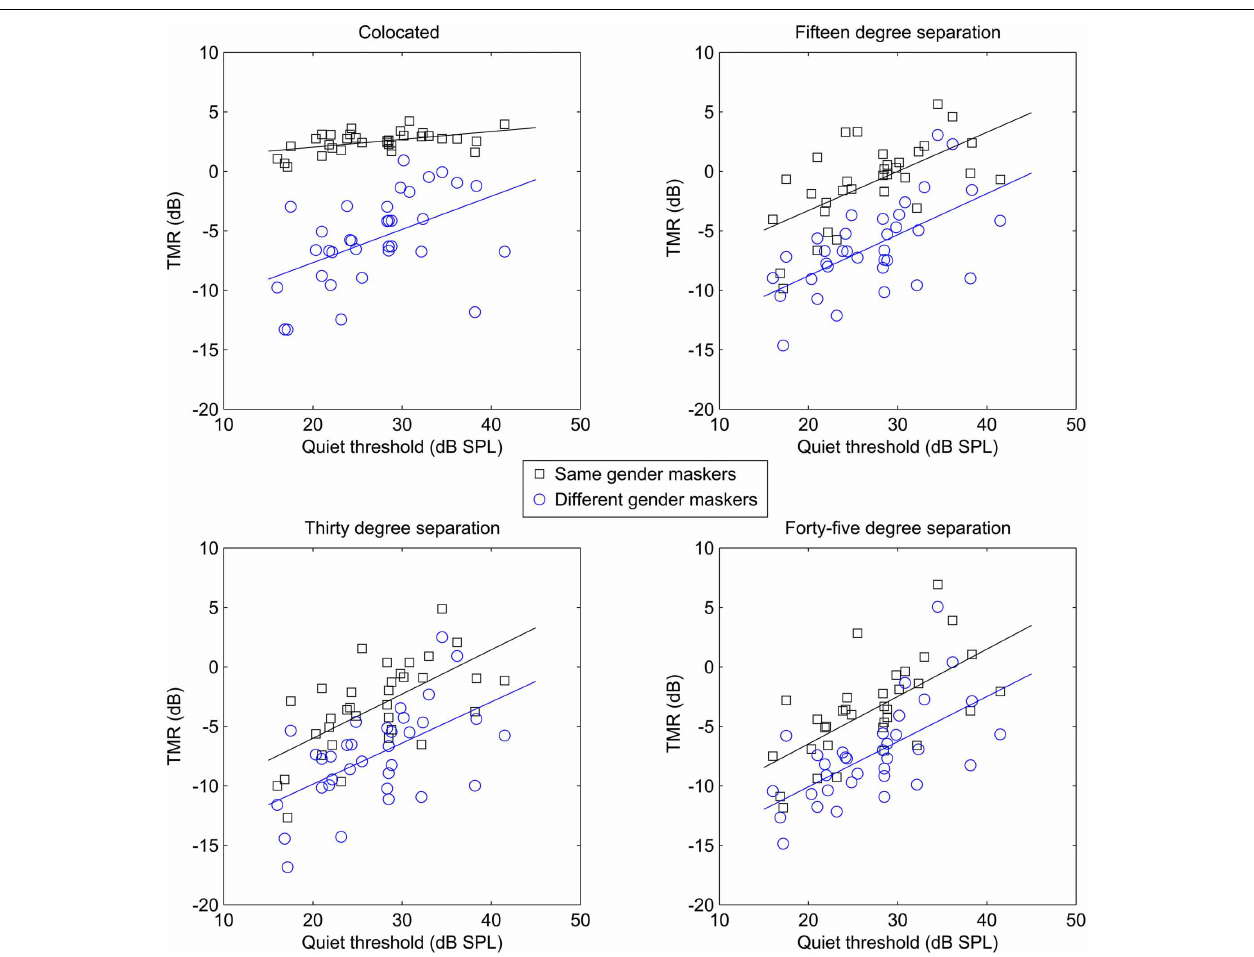
FIGURE 3 | Target-to-masker ratio (TMR) plotted as a function of quiet threshold for the subjects in Experiment One. Each panel plots same-gender maskers (averaged across target gender) as squares and different-gender maskers as